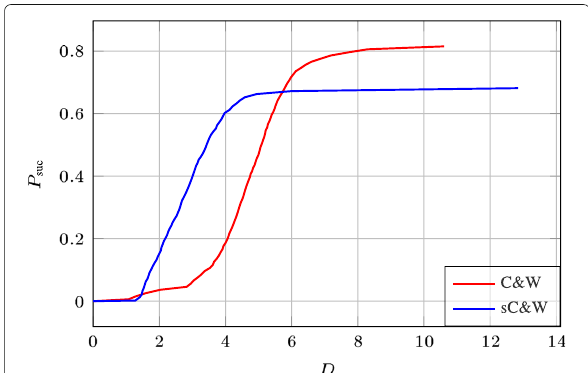
Fig. 7 Operating characteristics of C&W and sC&W on ImageNet with InceptionV3 under bilateral filter transferability, corresponding